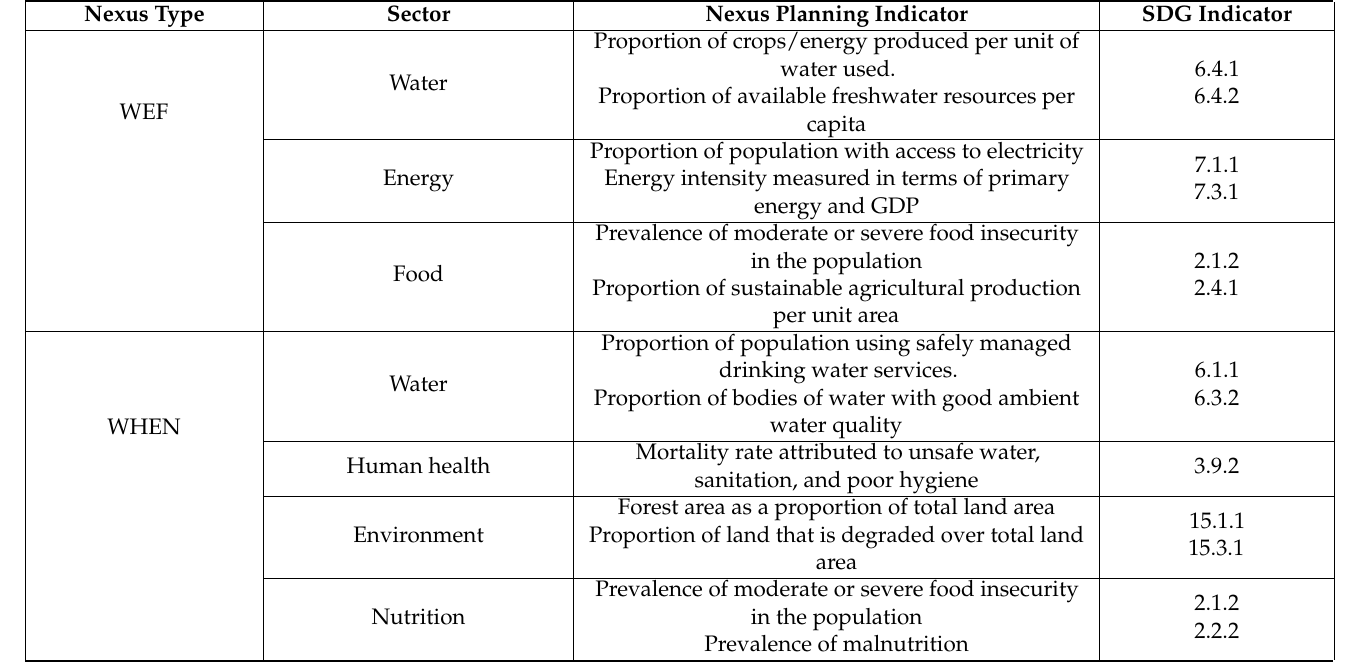
Table 1. WEF nexus indicators and pillars, and the linked SDG